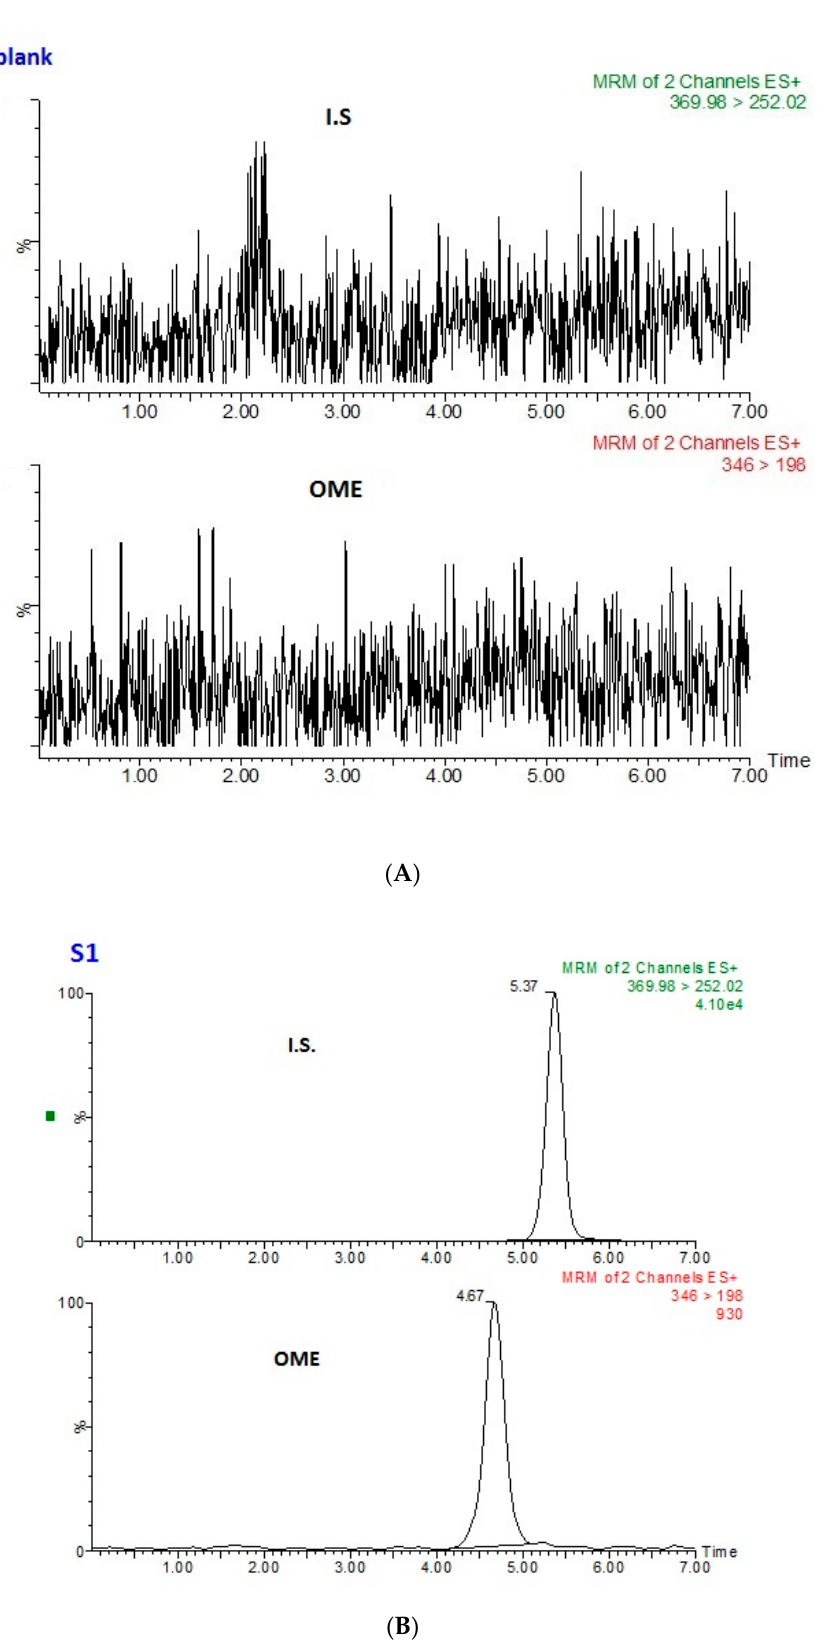
Figure 6. ( A ) Multiple reaction monitoring (MRM) transitions obtained from the analysis of a blank saliva sample, and ( B ) OME at 2 nmol L − 1 , (S1) with internal standard.